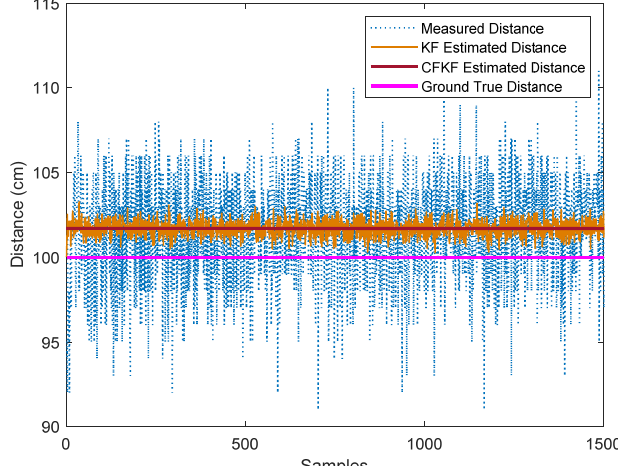
Figure 8. Error modelling calibration result comparison with different algorithms (UWB anchor 2).